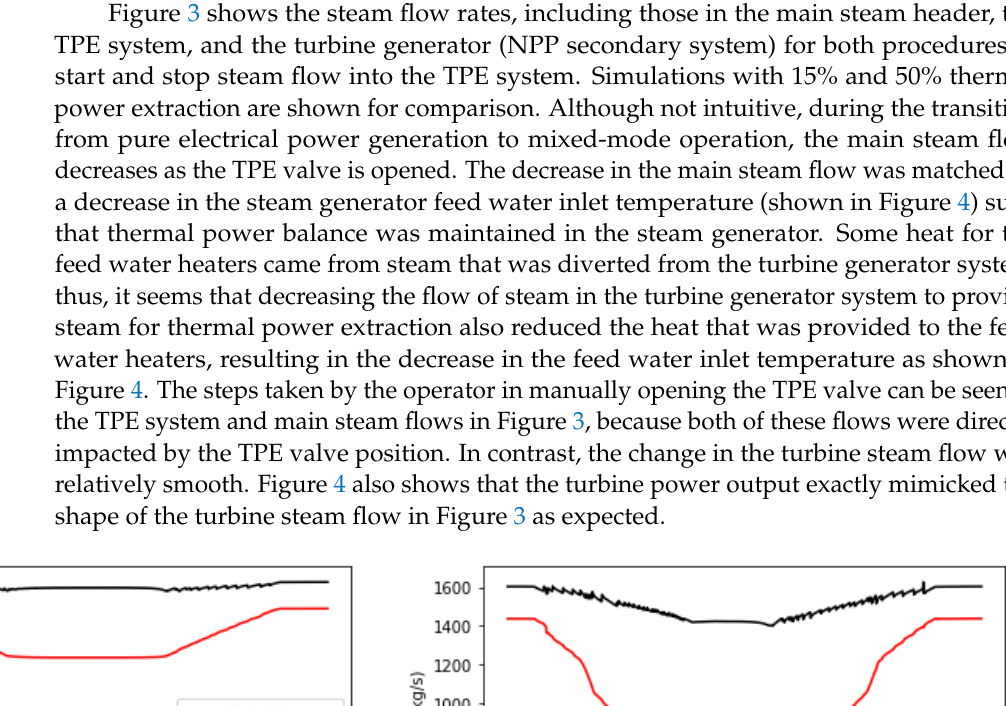
( b ) Figure 4. The steam generator feed water temperature and turbine power during the transitions between pure electric power generation and mixed-mode power generation. Results are shown for 15% TPE ( a ) and 50% TPE ( b ). The most surprising feature of Figure 4 was the large drop in the turbine power dur- ing mixed-mode operations. At 50% thermal power extraction, the power generation of the turbine dropped to 280 MW or approximately 30% of the full power capacity. This result indicates that extracting steam flow from the main steam header and returning the condensate from the TPE heat exchangers substantially derates the performance of the turbine generator system. At 15% thermal power extraction, the power generation of the turbine dropped to 773 MW or approximately 84% of the full power capacity. The addition of a new main steam load in the system necessitated a change in the calculation of the overall thermal efficiency of the modified system. This can be expressed according to Equation (2): 𝜂 𝑡𝑜𝑡 = 𝐸 𝑛𝑒𝑡 + 𝜂𝑄 𝑡𝑝𝑒 𝑄 𝑖𝑛 (2) The added variables to change Equation (1) into Equation (2) were 𝜂 , which is the efficiency of thermal power dispatch, assumed to be 95% due to the losses in the heat transport system, and 𝑄 𝑡𝑝𝑒 , which is the thermal power transferred to the thermal power dispatch system. The new plant efficiency ( 𝜂 𝑡𝑜𝑡 ) was the overall thermal efficiency of the